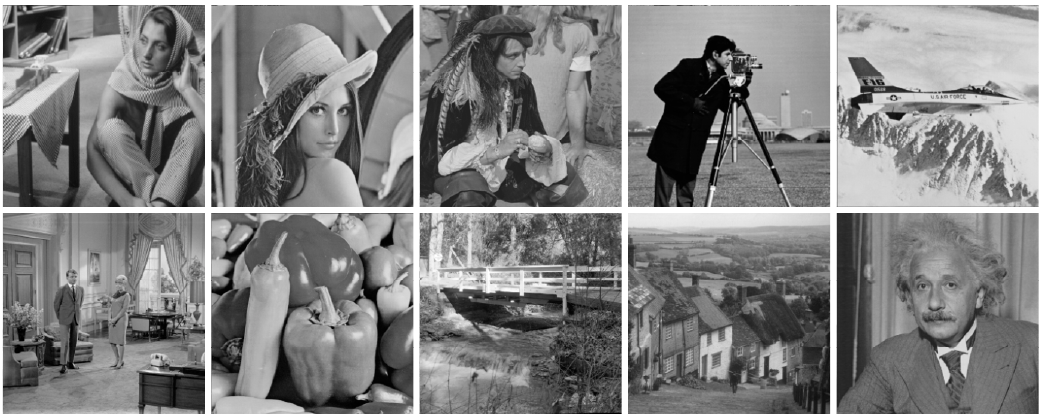
Figure 7. Classic standard test images for synthesized noisy images: “Barbara,” “Lena,” “Pirate,”